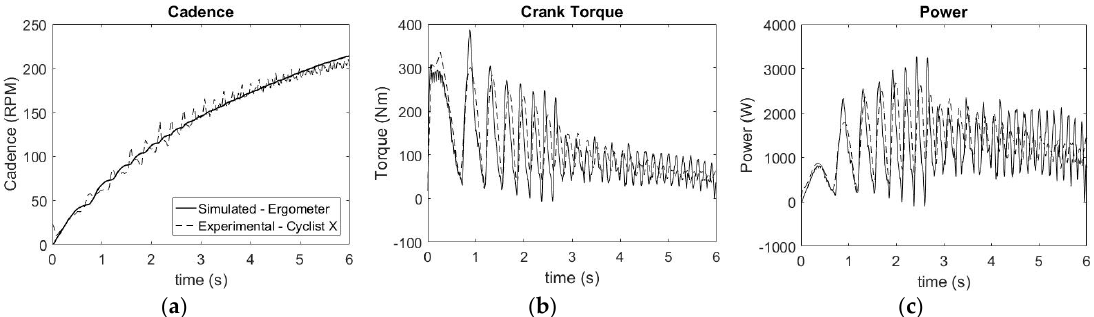
Figure 3. Comparison of mechanical outputs at the crank between simulated ergometer pedaling and a single experimental trial for Cyclist X. ( a ) Cadence; ( b ) Torque; ( c ) Power.